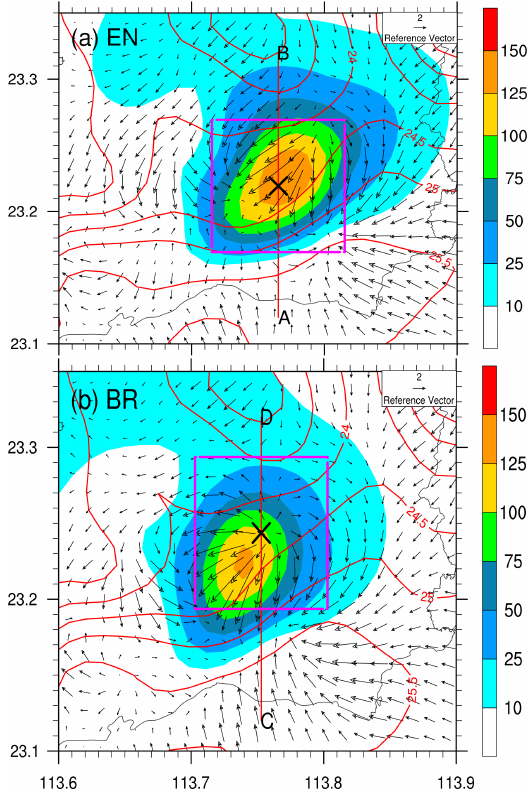
Figure 6. Spatial distribution of hourly rainfall amount (mm; shad- ings), temporally averaged surface temperature (contoured at 0.5 ◦ C intervals), and horizontal wind fields (vectors) during the period from 06:00 to 07:00BST 7 May 2017. The red lines, A–B (a) and C–D (b) , indicate the locations of the vertical cross-section in Fig. 7. The two pink square boxes, covering an area of 0 . 1 ◦ × 0 . 1 ◦ with the centre of the maximum hourly rainfall, are marked for domain- averaged calculation in Figs. 8 and